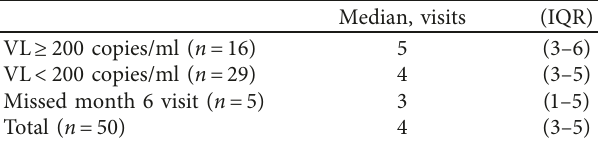
Table 7: Visit burden at month 6